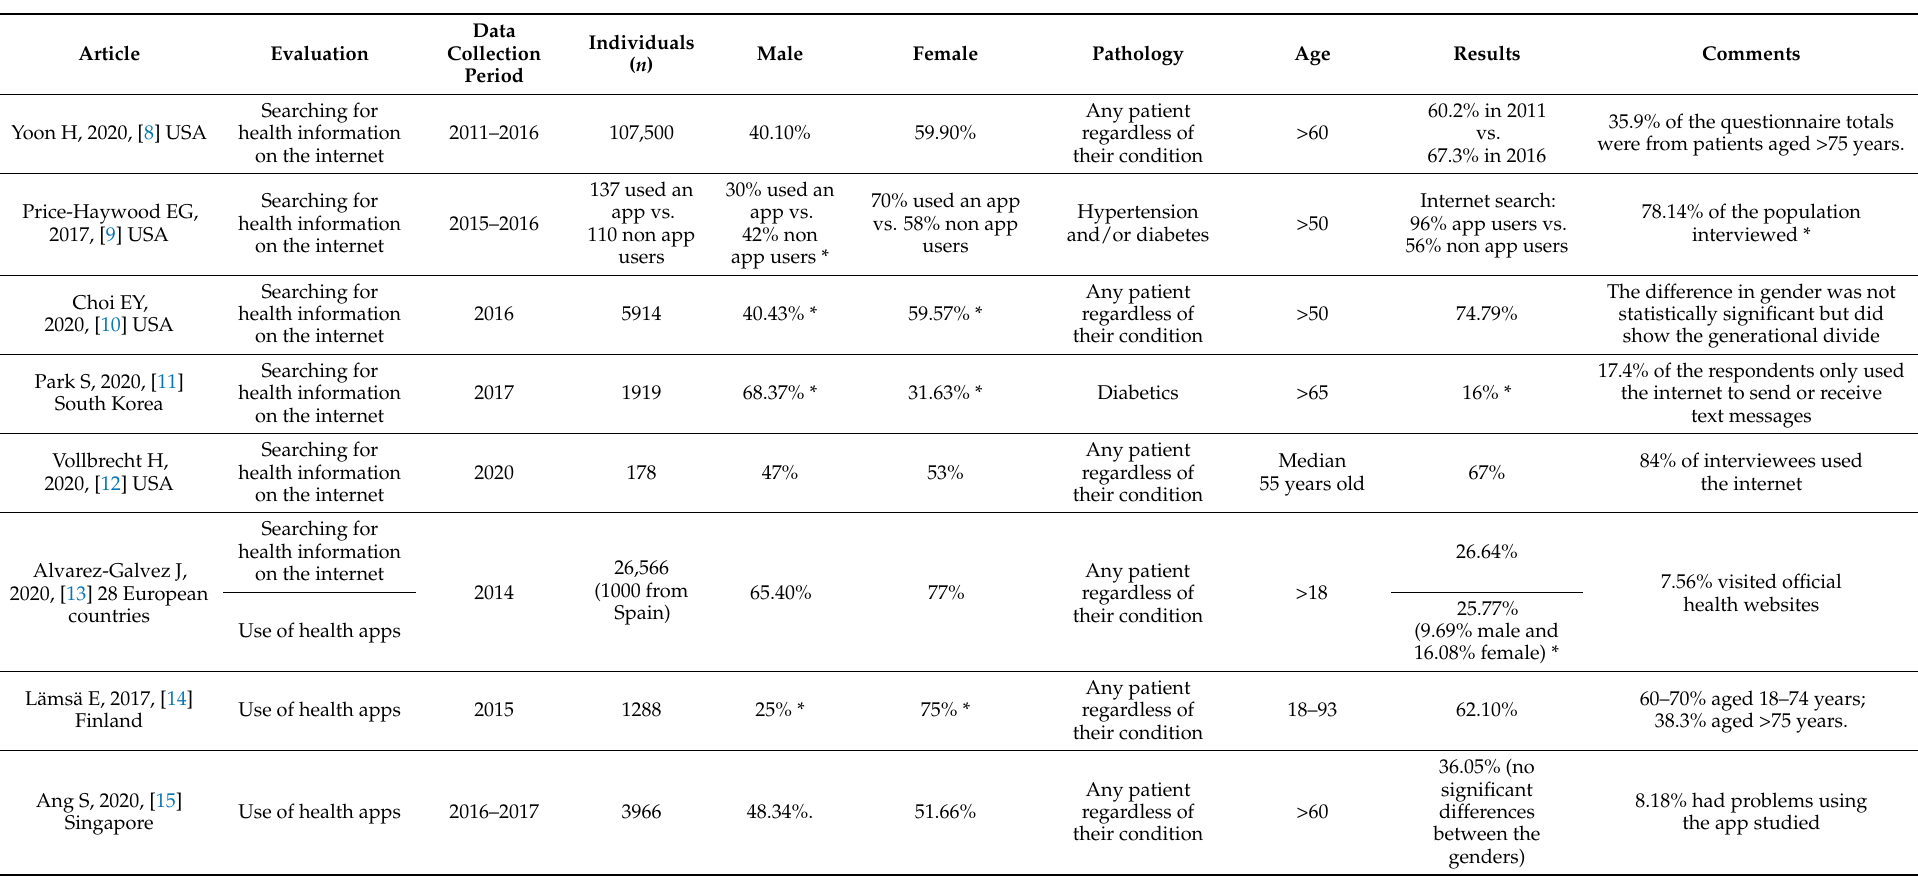
Table 2. Evaluation of the use of the internet to search for health information, use of medical apps, and telemedicine. All the data from these studies were collected through